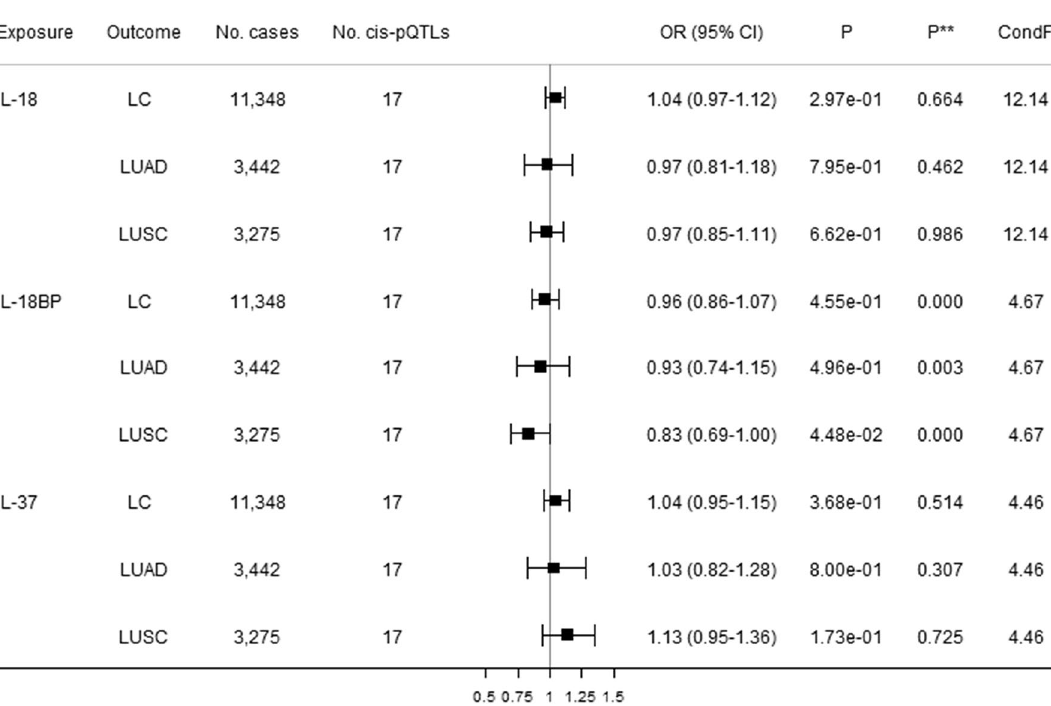
Figure 4. Direct causal estimates of genetically predicted IL-18, IL-18BP, and IL-37 with lung cancer (LC) and its subtypes [lung adenocarcinoma (LUAD) and squamous cell lung cancer (LUSC)] using robust multivariable MR analyses. Cis -pQTLs is cis protein quantitative loci. P ** indicates a pleiotropy test based on the MVMR Egger. ConF indicates the overall conditional F-statistic. The modified Q-statistic for LC, LUAD, and LUSC are respectively 28.00 ( P = 0.022), 13.53 ( P = 0.562), and 18.99 ( P =